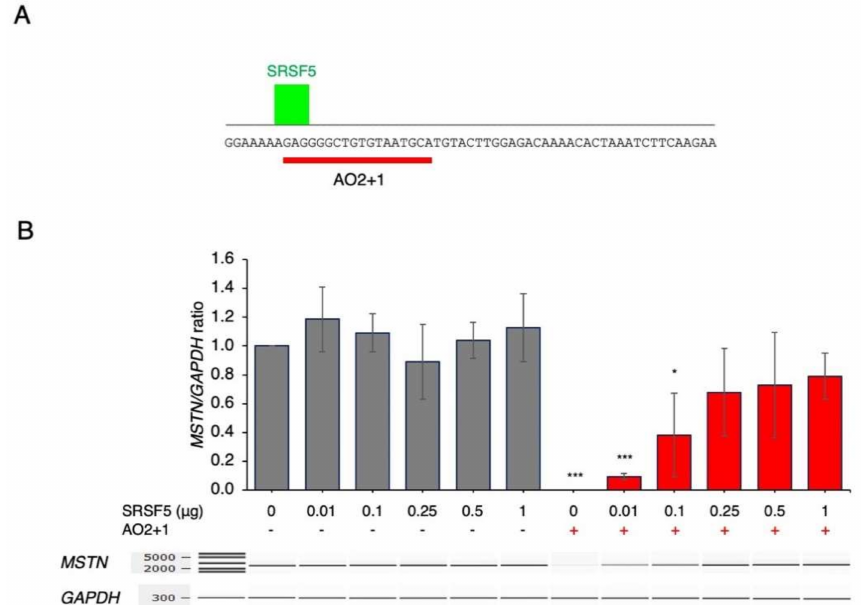
Figure 3. SRSF5 restored the inhibition mediated by AO2+1. ( A ). Characterization of splicing regulatory factors. The nucleotide sequence around the AO2+1 target site was analyzed for splicing enhancer and silencer sequences with SpliceAid2. The output graph is shown. The nucleotide sequences of exon 1 are described in uppercase letters. The binding location of SFRF5 is indicated by a green bar, and the binding strength is represented by the height. A red bar indicates the target site of AO2+1. ( B ). CRL–2061 cells were transfected with different doses of SRSF5 plasmid with or without AO2+1. A fragment extending from exon 1 to exon 3 was RT–PCR amplified. Electrophoretograms of the amplified products are shown (bottom). The amount of product was calculated and is expressed as the ratio of MSTN to GAPDH . The ratio increased with increasing plasmid dose and reached 0.8 at 1 µ g of the plasmid. * = p < 0.05, *** = p < 0.001 vs. 0 µ g SRSF5 and no ASO